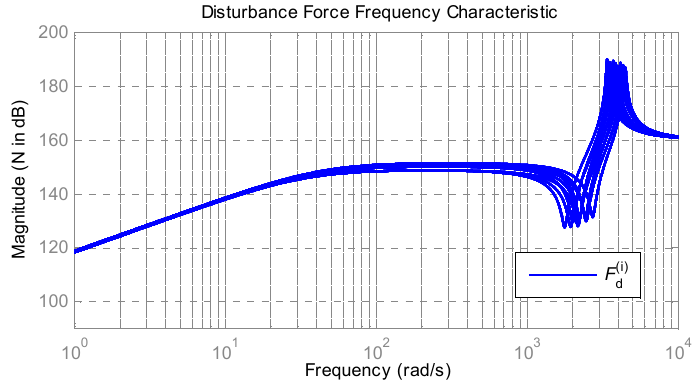
Figure 5. Frequency characteristic set of the extraneous force with uncertainty.